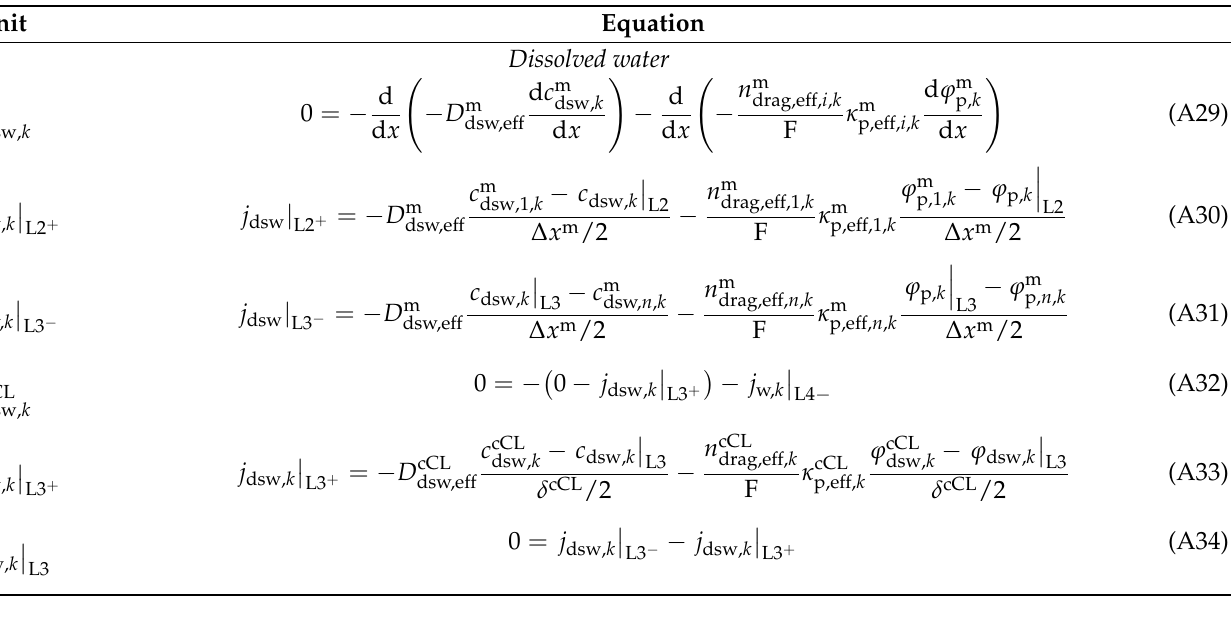
Table A2. Additional cathode channel